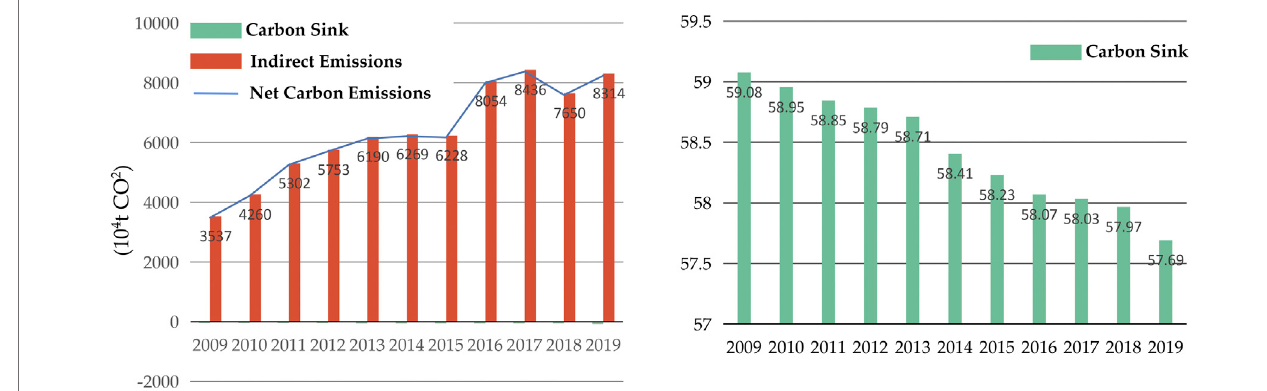
FIGURE 2 | Carbon sink and net carbon emissions from land use, 2009 – 2019.